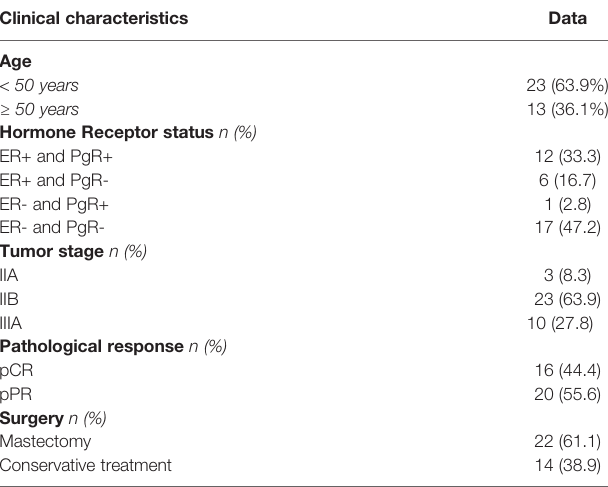
TABLE 1 | Patients and tumor